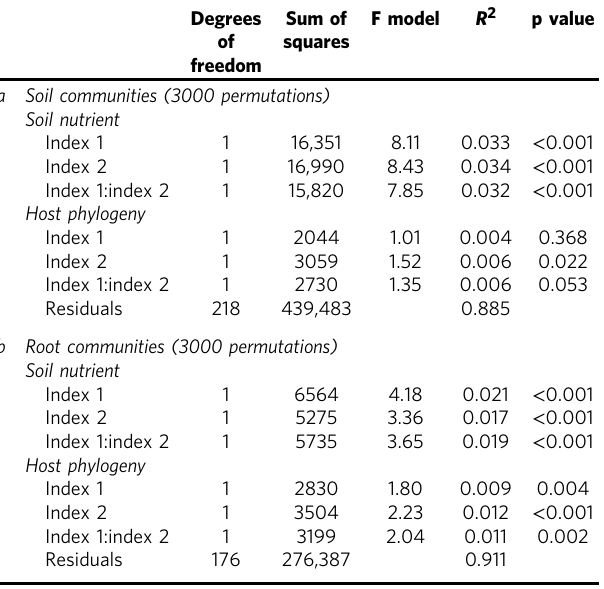
Values in table derived from permutational multivariate analysis of variance (PERMANOVA).